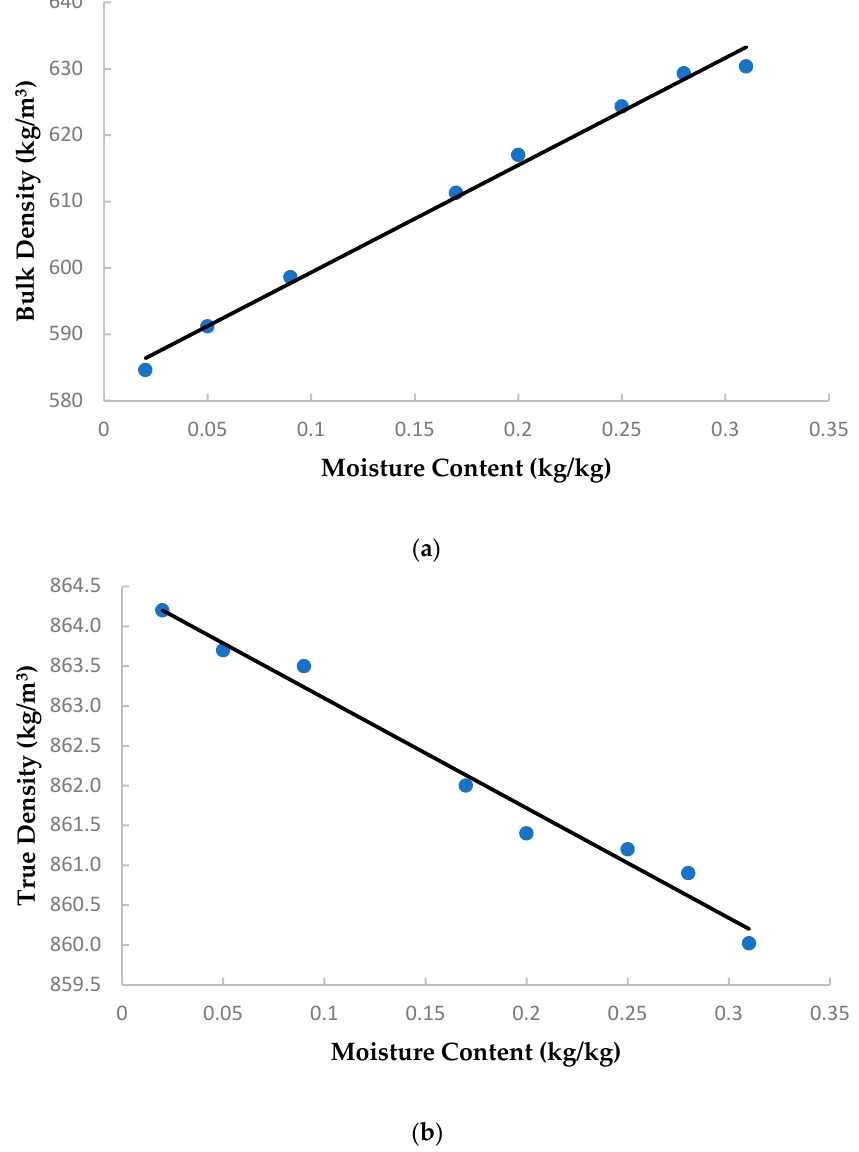
Figure 4. ( a ) Bulk density of palm kernel, ( b ) true density of palm kernel at different moisture contents.